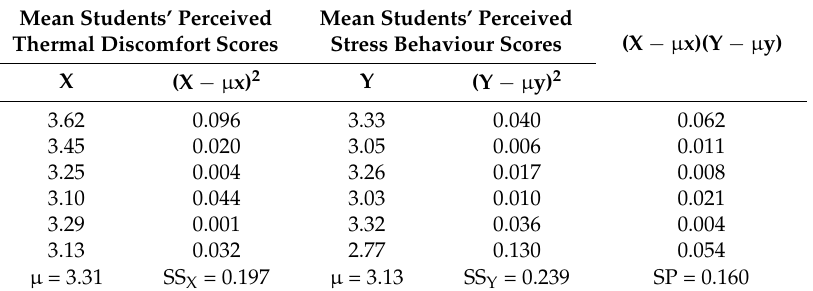
Table 5. Test of correlation between students’ perceived thermal discomfort level and students’ perceived stress behaviour levels affecting learning in LTH-2.